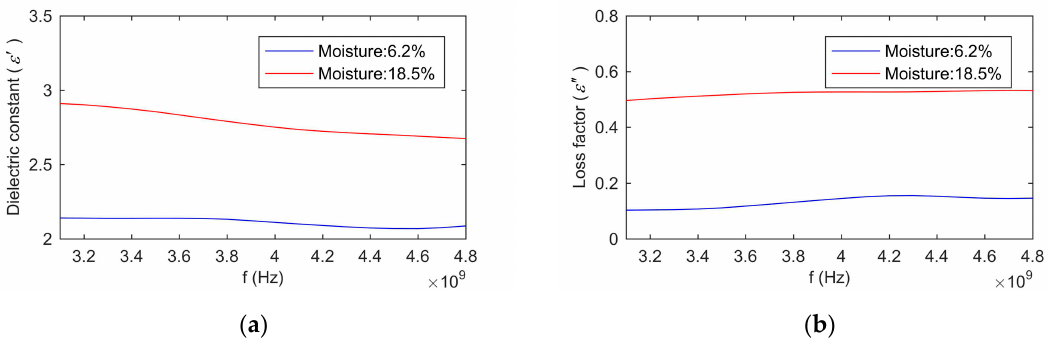
Figure 20. The dielectric constant of wheat with the moisture content of 6.2% and 18.5%: ( a ), dielectric constant; ( b ), loss factor.